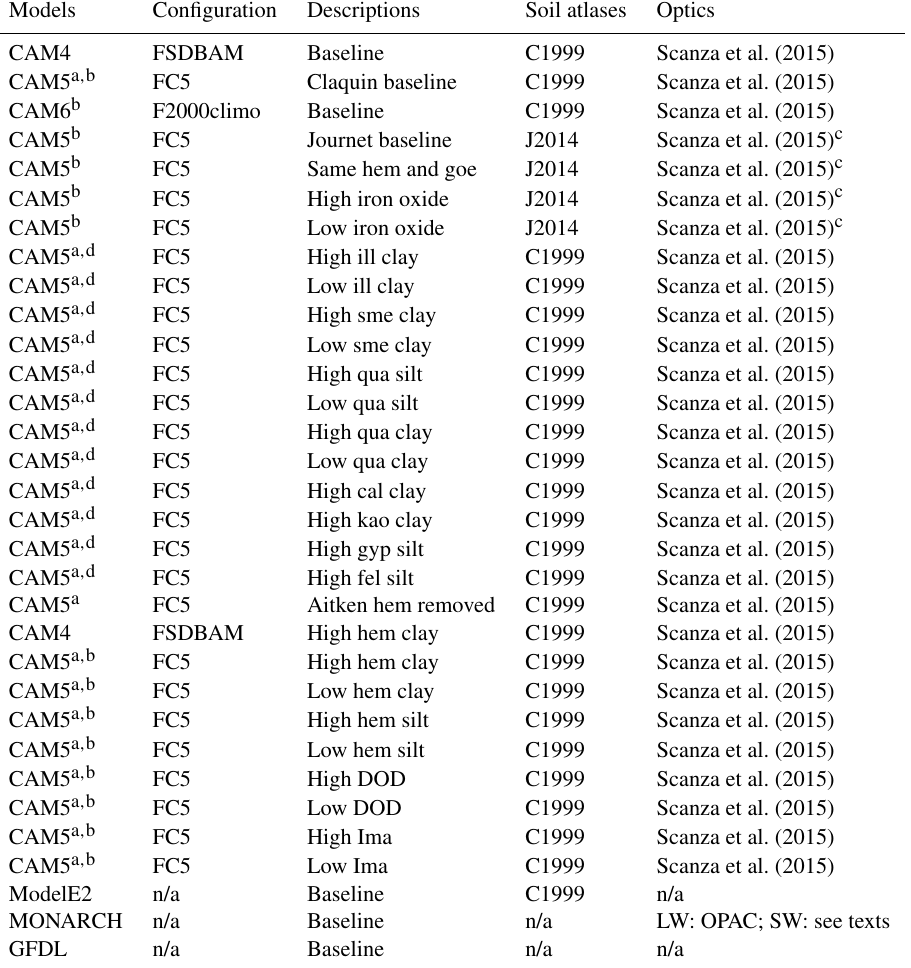
Table 2. List of experiments for the sensitivity test using CAMs (CAM4, CAM5, and CAM6), ModelE2, MONARCH, and GFDL with speciated (indicated by C1999 and J2014) and bulk dust. All the model results were processed onto 2.5 ◦ × 1.9 ◦ (longitude by latitude) horizontal grids for further calculation. Note: Ima – imaginary; LW – longwave; SW – shortwave; OPAC – Optical Properties of Aerosols and